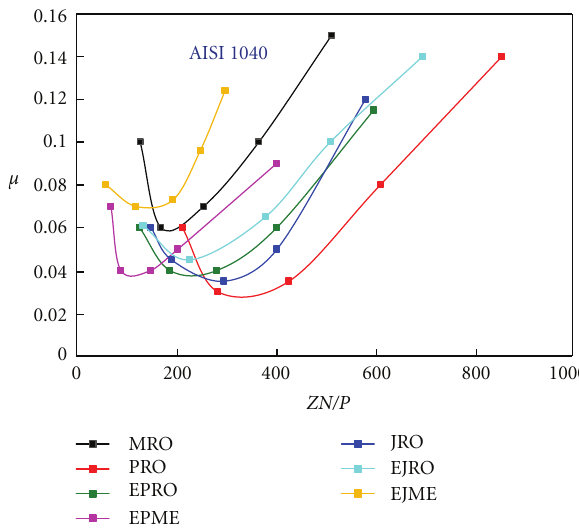
Figure 9: Stribeck curves for AISI 1040.